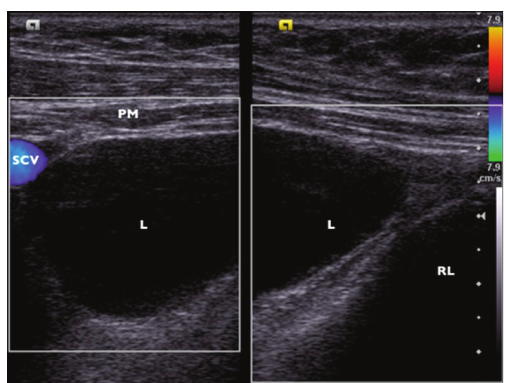
Figure 2: Chest CT with intravascular contrast, sagital view. PM: pectoral muscle; L: lymphocele; RL: right lung; SCV: subclavian vessels.